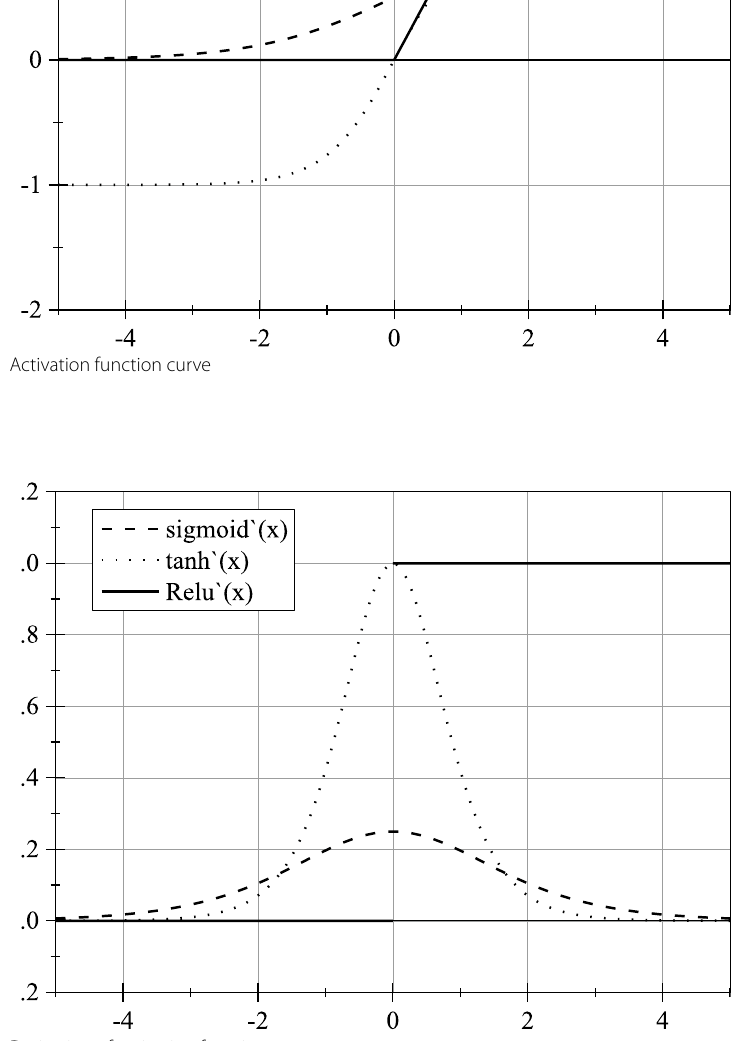
Fig. 11 Derivation of activation function